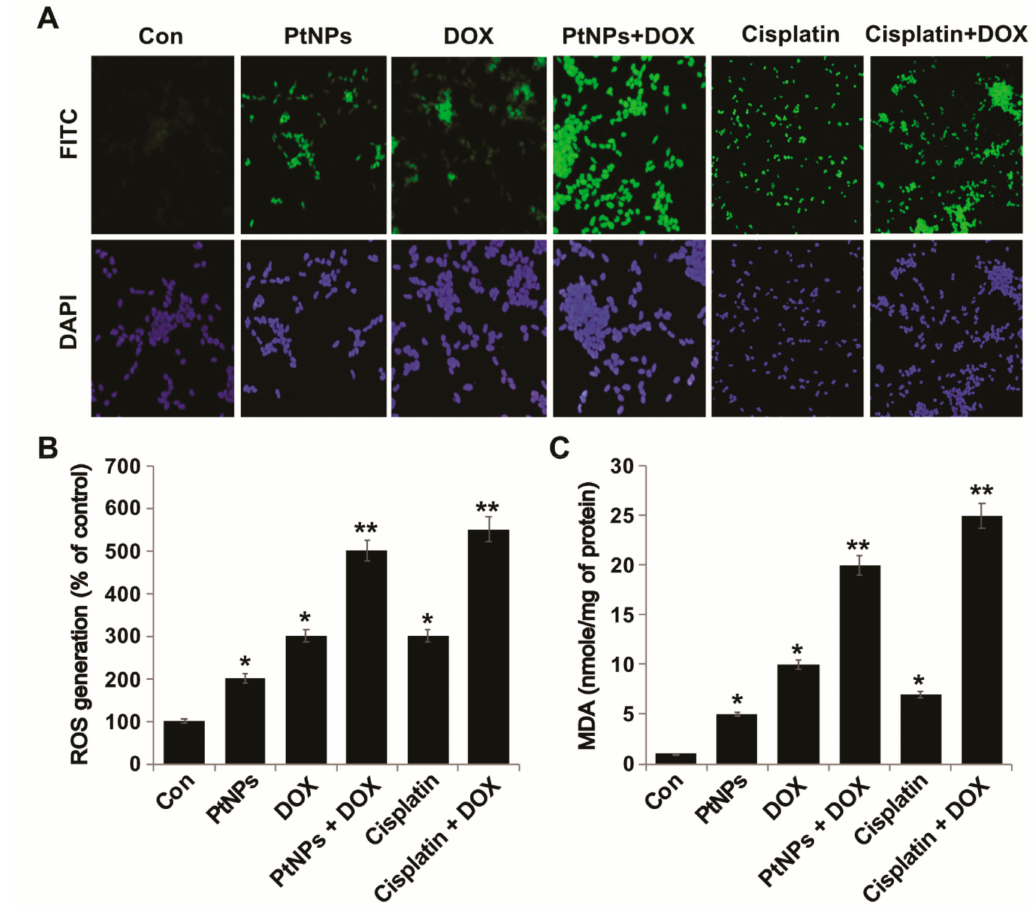
Figure 8. PtNPs and DOX induce ROS generation and lipid peroxidation in U2OS cells. U2OS cells were treated with PtNPs (10 µ g / mL), DOX (1 µ g / mL), CIS (5 µ g / mL), or a combination of PtNPs (10 µ g / mL) and DOX (1 µ g / mL) or combination of DOX (1 µ g / mL) and CIS (5 µ g / mL) for 24 h. ( A ) ROS generation was measured using DCFH-DA-FITC with fluorescence microscopy. ( B ) Spectrophotometric ROS analysis was performed using DCFH-DA. ( C ) MDA concentrations were measured using a thiobarbituric acid-reactive substances assay and expressed as nanomoles per milliliter. Di ff erences between the treated and control groups were measured using Student’s t -test and statistically significant di ff erences are indicated by * ( p < 0.05). The results are presented as mean ± standard deviation of three experiments. * p < 0.05 was considered significant; ** p < 0.01 was considered highly significant and *** p < 0.001 was considered very highly significant. Scale bar: 200 µ